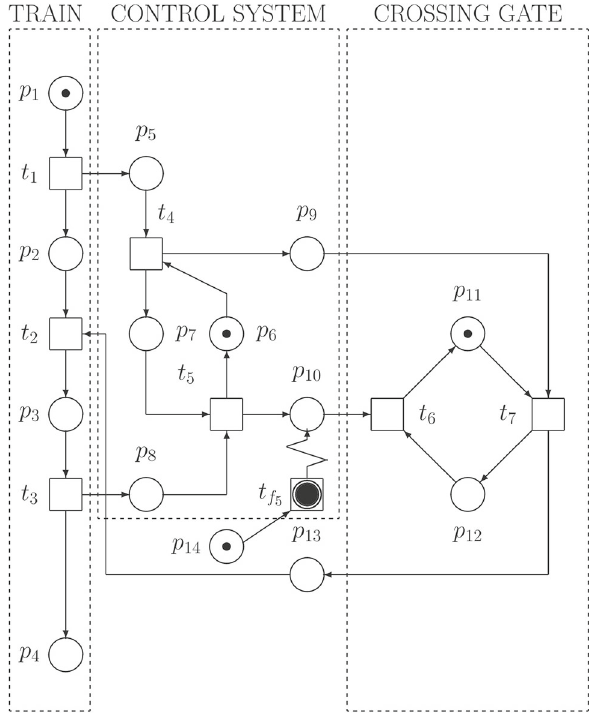
Fig. 3 The coverability tree (left) and coverability graph (right) of the PN model with t f failure